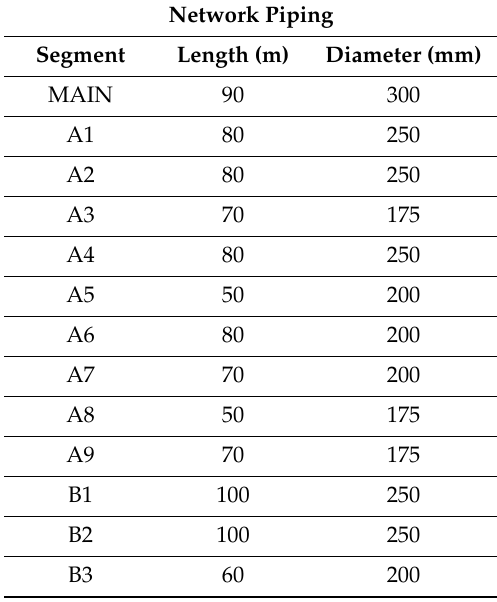
Table A1. Lengths and diameters of the main line and of the pipes of the